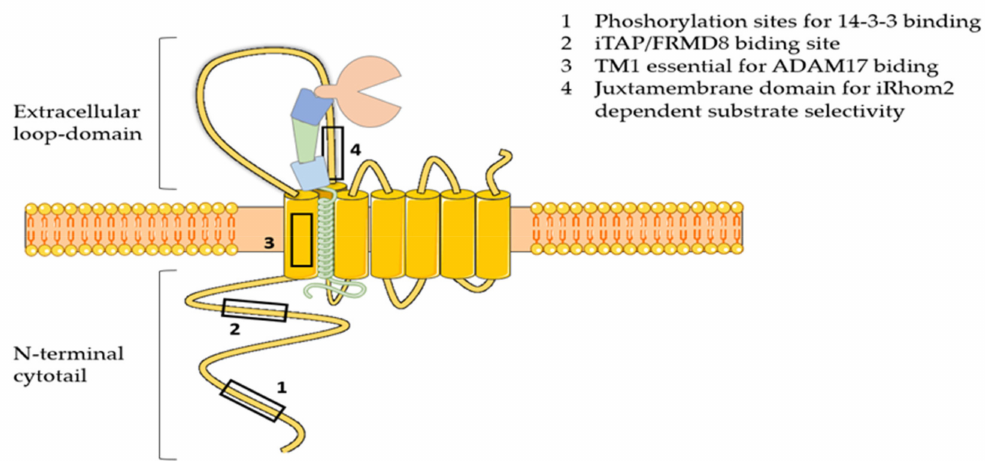
Figure 2. Schematic representation of iRhom2. iRhom2 comprises 7 transmembrane domains (TM1-7), the first of which is crucial for the interaction with ADAM17. In addition, iRhom2 exhibits a number of unique features compared to rhomboids that are essential for regulating the activity of the protease: 1) the N-terminal cytotail, which contains the phosphorylation sites for binding of 14-3-3 proteins and the iTAP/FRMD8 binding site; 2) the large extracellular loop domain between the first and the second transmembrane domain, which harbors a sequence that is essential for iRhom2- dependent substrate